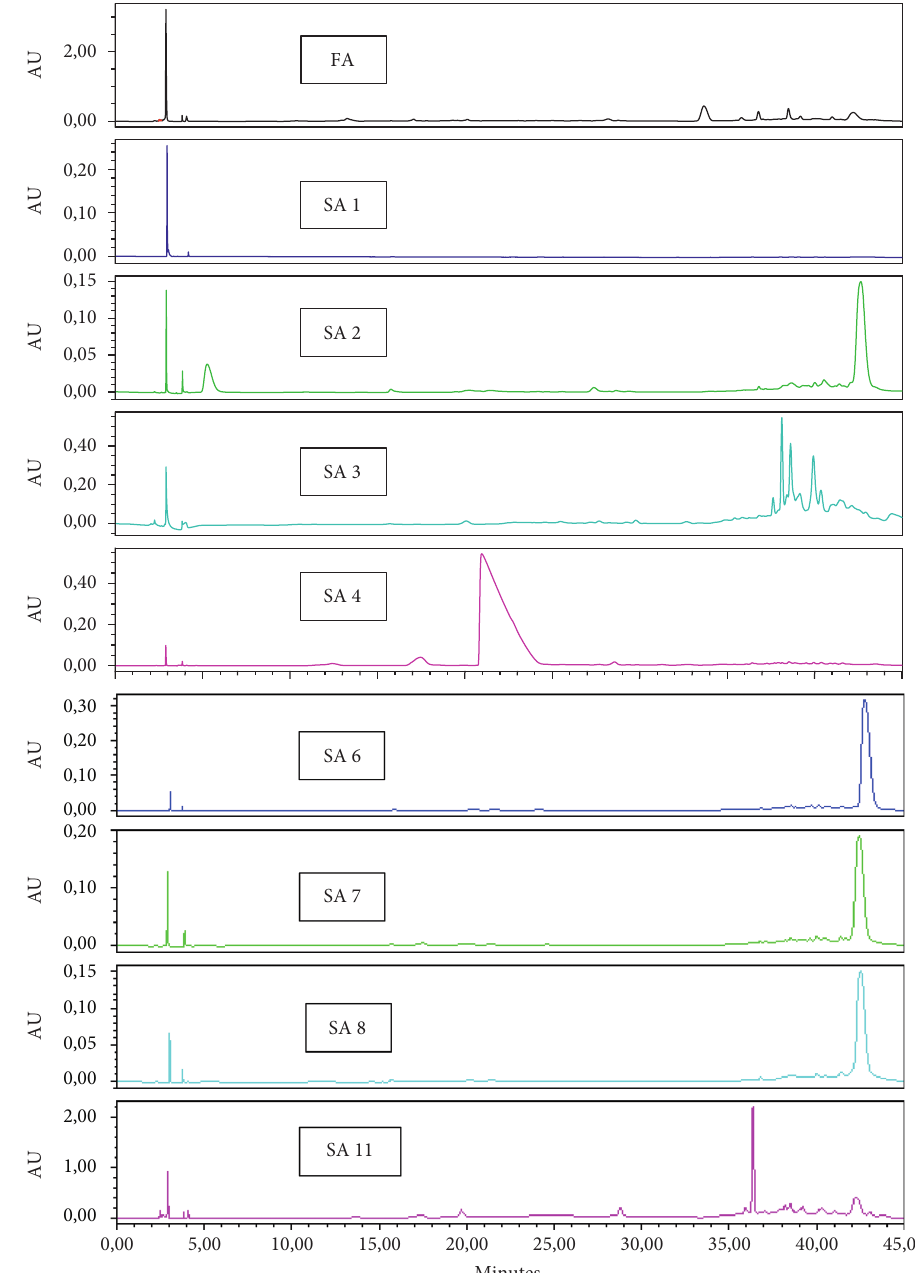
Figure 2: HPLC chromatograms fractions generated from the acetone mother extract FA